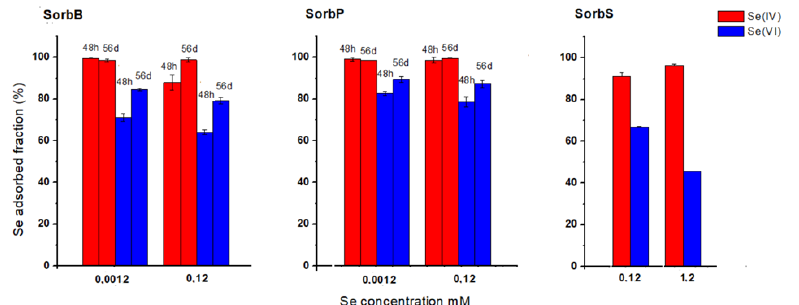
Figure 2. Fraction of adsorbed Se(IV) and Se(VI) in single-species experiments with SorbB, SorbP and SorbS (1 g/L) as a function of initial Se concentration (0.0012, 0.12 and 1.2 mM) and reaction time (48 h and 56 d) at pH 3. Experiments with SorbS lasted only 48 h.